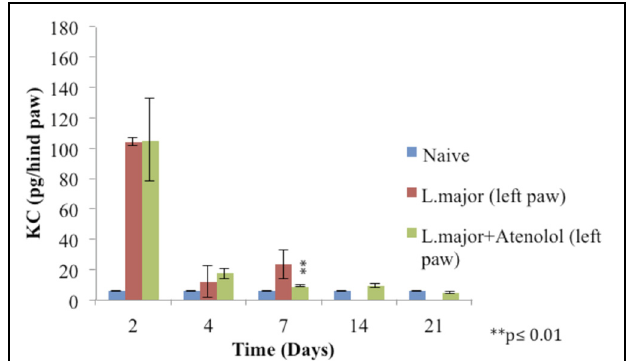
FIGURE 8 | Effect of the daily i.p. injection of atenolol on the level of KC in the paws of mice infected with high dose (4 × 10 6 promastigotes/50 μ l nutrient broth medium/left hind paw) of L. major : paws removed from the left paws of mice. Mice were injected with 2.0 mg/kg of atenolol (i.p.) for 7 consecutive days and the levels of KC were assessed at days 2, 4, 7, 14, and 21 post-infection (at day 14 and 21 the level of KC in the group infected is not detected). Each result is the mean of 5 mice ± SEM and the degree of significance was calculated with reference to atenolol non-treated